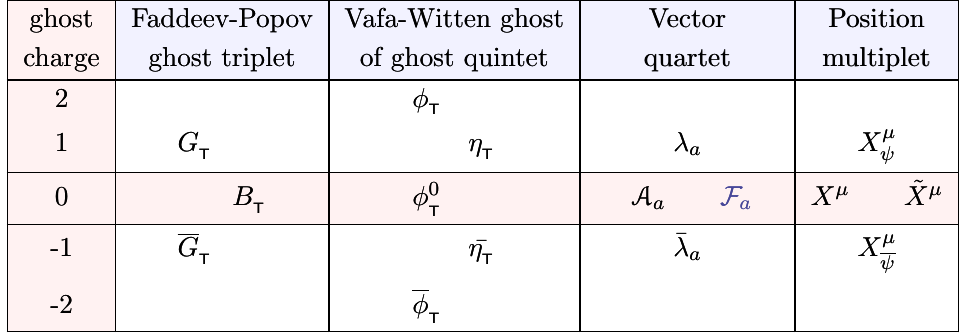
Table 1 . The set of basic (cid:12)elds in the = 2 superalgebra along with their respective ghost N T number assignments, in terms of which the hydrodynamic e(cid:11)ective action is